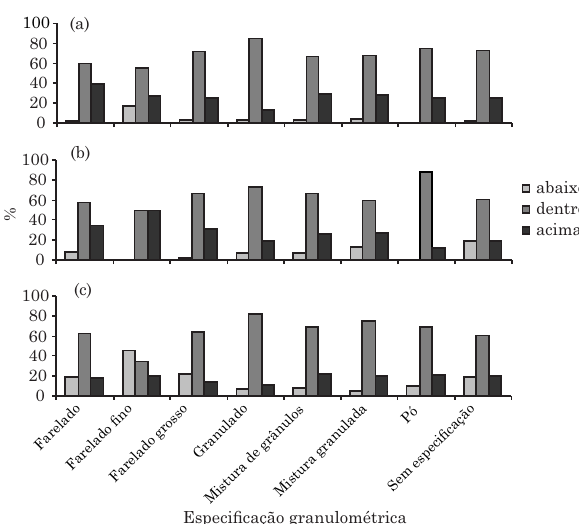
Figura 3. Frequências das conformidades das análises fiscais, por especificação granulométrica, para o nitrogênio (a), fósforo (b) e potássio